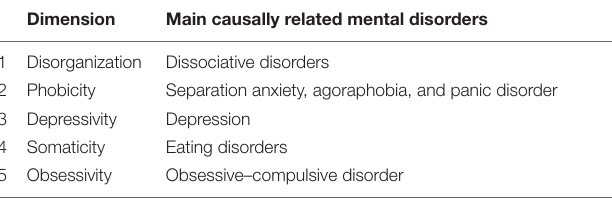
TABLE 5 | Attachment dimensions that can be a cause of a mental